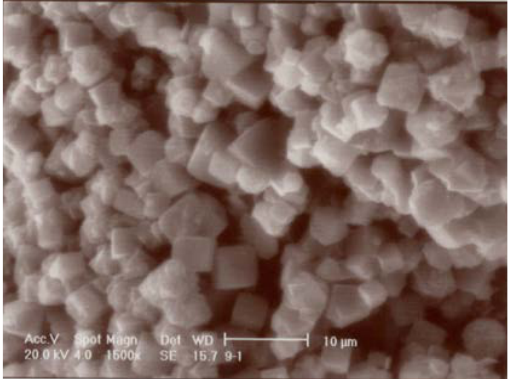
Fig. 8. SEM micrograph of the membrane surface ٦